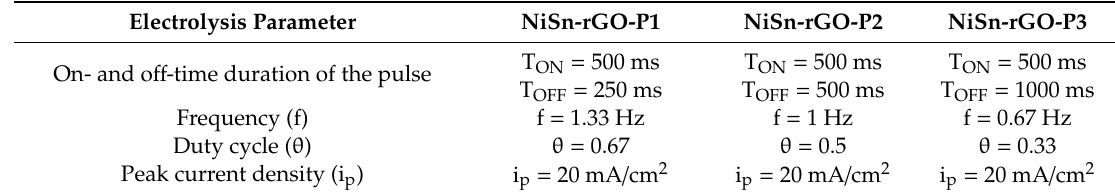
Table 2. Operating parameters for the electrodeposition of NiSn-rGO from ILEG, t = 30 min and a constant peak current density.